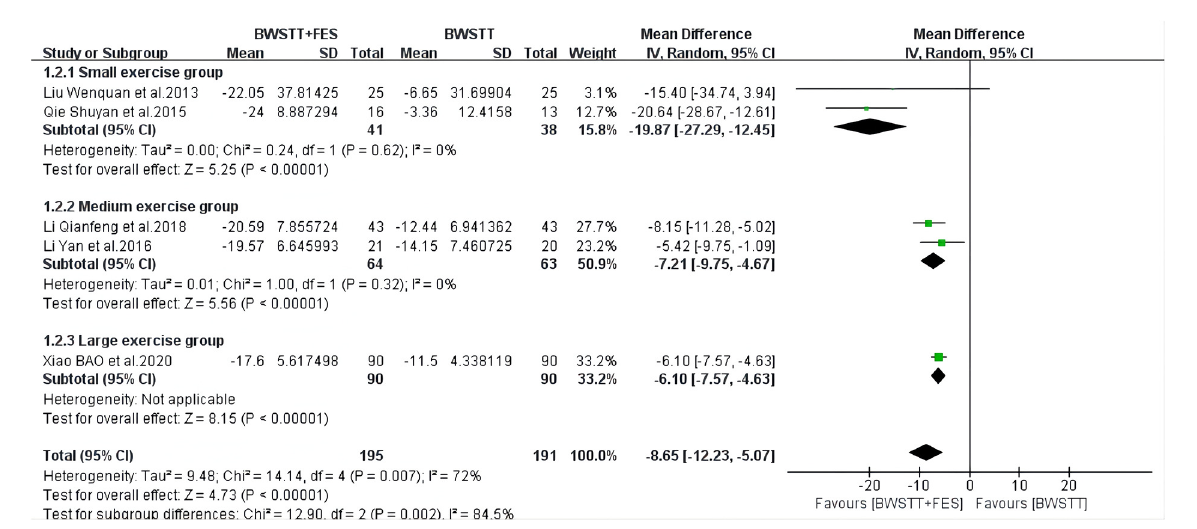
FIGURE5 Forest plot showing the effect on Fugl-Meyer Assessment (FMA) of body weight support treadmill training combined with functional electrical stimulation (BWSTT + FES) vs. body weight support treadmill training (BWSTT). CI, confidence interval; SD, standard deviation.